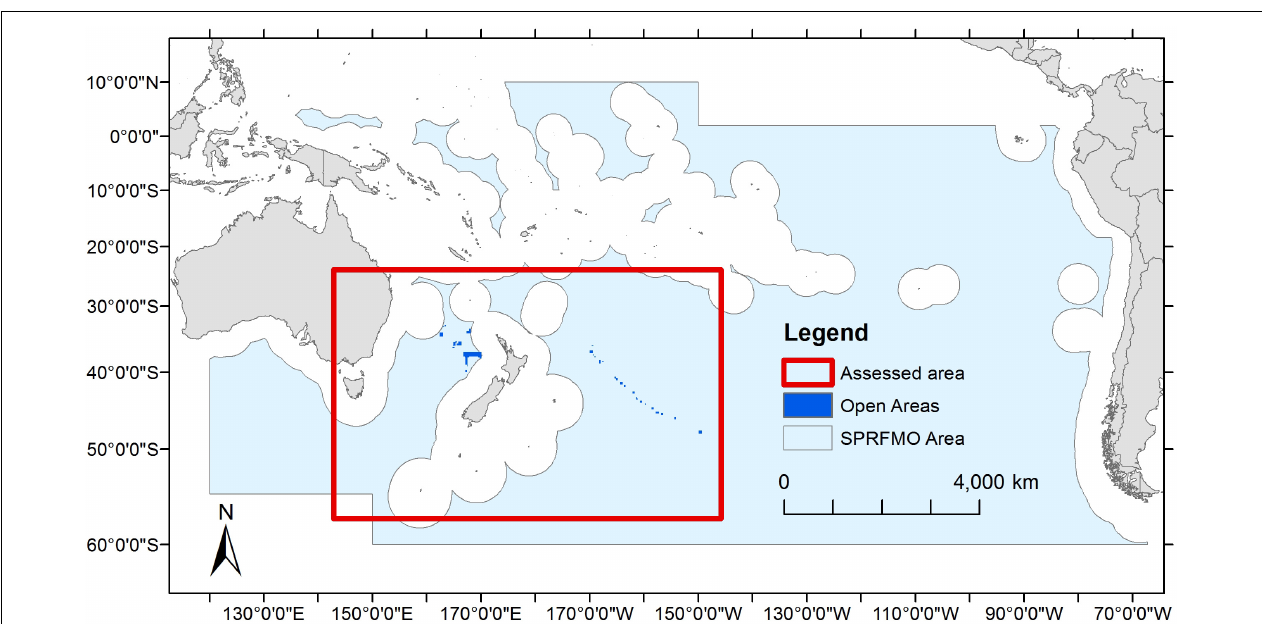
FIGURE 1 | The SPRFMO Convention Area with the location of the assessed area from within which data collected by scientific observers from 9,771 New Zealand bottom trawl tows over the period 2008–2018 was used in this analysis. Also shown as dark blue polygons are the locations of areas open to bottom trawling under SPRFMO